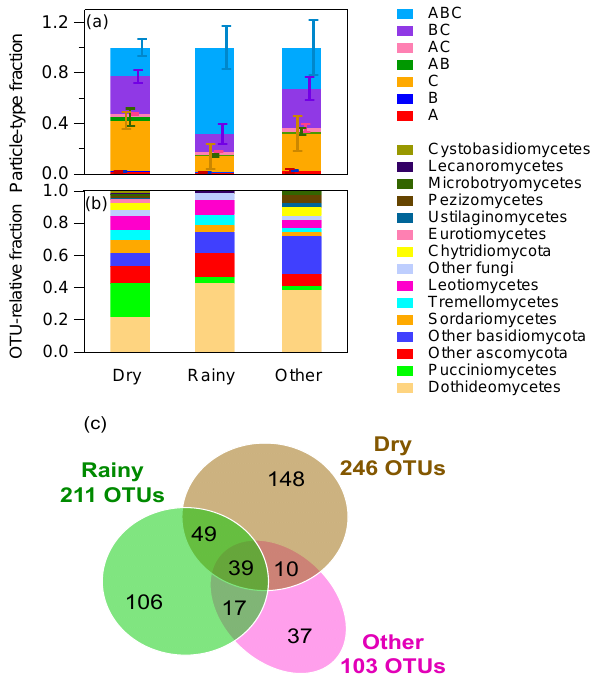
Figure 3. Characteristic differences between wetness periods (Dry, Rainy, Other). (a) Relative fraction of fluorescent particle number corresponding to each WIBS category. Bars show relative standard deviation of category fraction in each wetness group (Dry, 19 sam- ples; Rainy, 11 samples; Other, 6 samples). (b, c) Distribution of fungal OTU (operational taxonomic unit) values. (b) Fungal com- munity composition at phylum and class level with Agaricomycetes (dominant class with consistently ∼ 60% of diversity) removed. Relative proportion of OTUs assigned to different fungal classes and phyla for each sample category shown. (c) Venn diagram show- ing the number of unique (wetness category-specific) and shared OTUs (represented by numbers in overlapping areas) among the sample categories (Dry, 11 samples; Rainy, 7 samples; Other, 3 sam- ples). OTUs classified as cluster of sequences with ≥ 97% similar- ity. Taxonomic assignments were performed using BLAST against NCBI database. In total, 3902 sequences, representing 406 fungal OTUs from 3 phyla and 12 classes were detected. Despite differ- ences in community structure across the sample categories, phylo- genetic representation appears largely